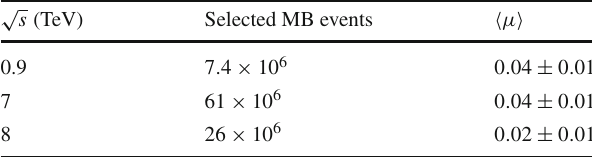
Table 1 Data samples used in this analysis. For each center-of-mass energy, the total number of selected minimum-bias (MB) events along with the average number of interactions per bunch crossing, (cid:3) μ (cid:4) , are listed